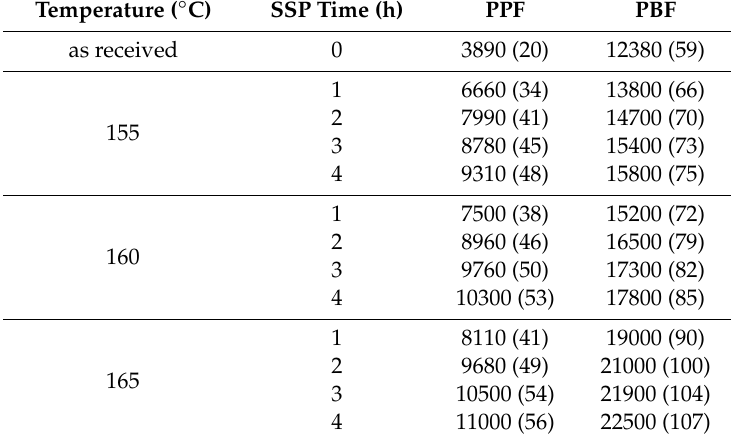
Table 1. Number average molecular weights (Mn, g / mol) of PPF and PBF polyesters obtained after SSP at di ff erent temperatures and times. The average degree of polymerization is also included in the